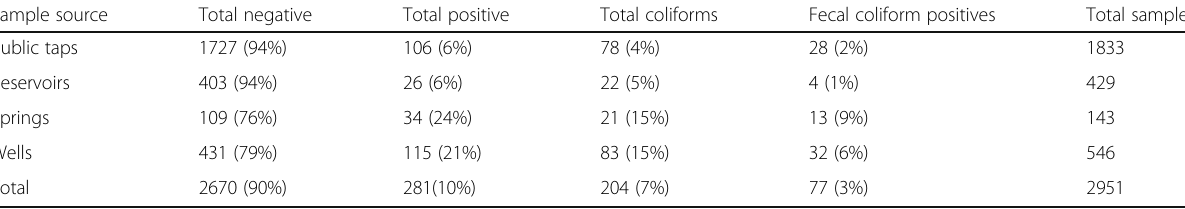
Table 1 The four sources (public tabs, reservoirs, springs, wells) results of public municipal drinking water in Addis Ababa, 2016 Sample